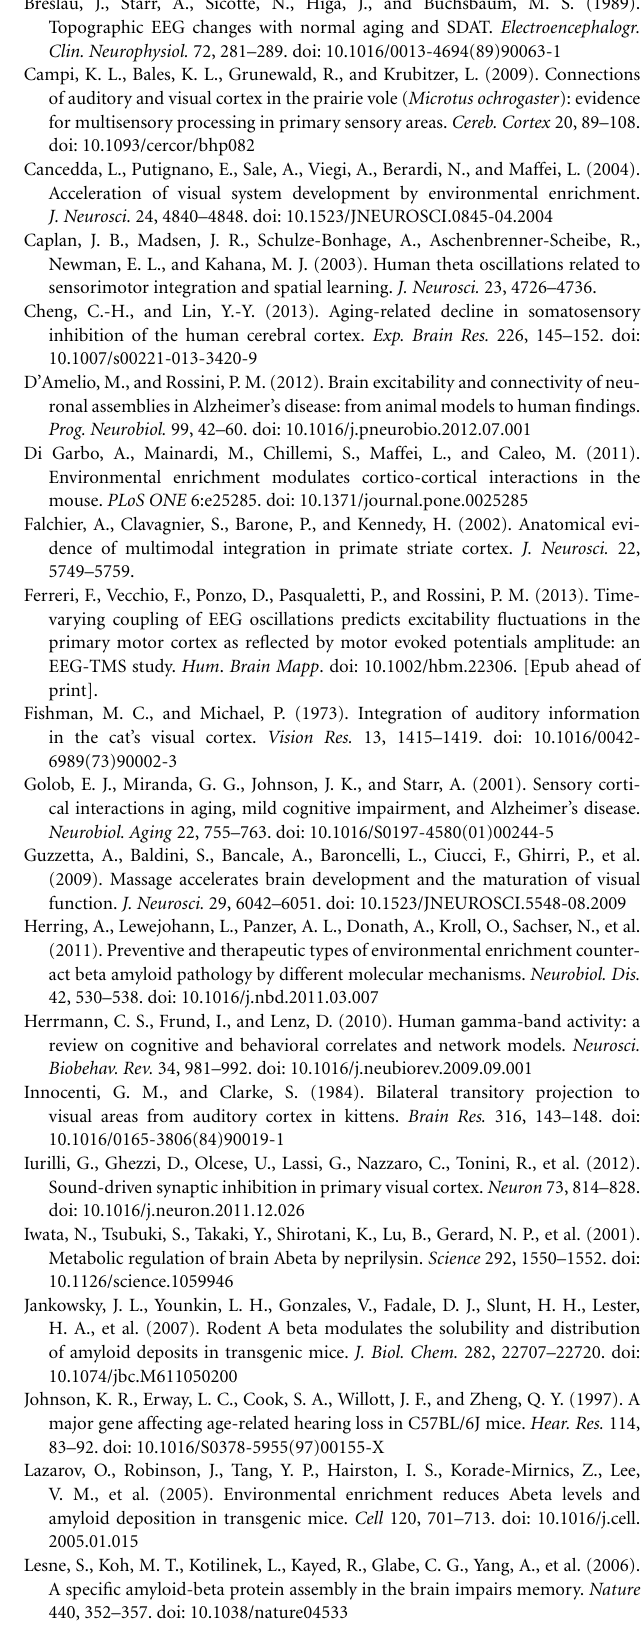
Figure S1 | Fourier analysis of spectral power in α and β EEG bands.